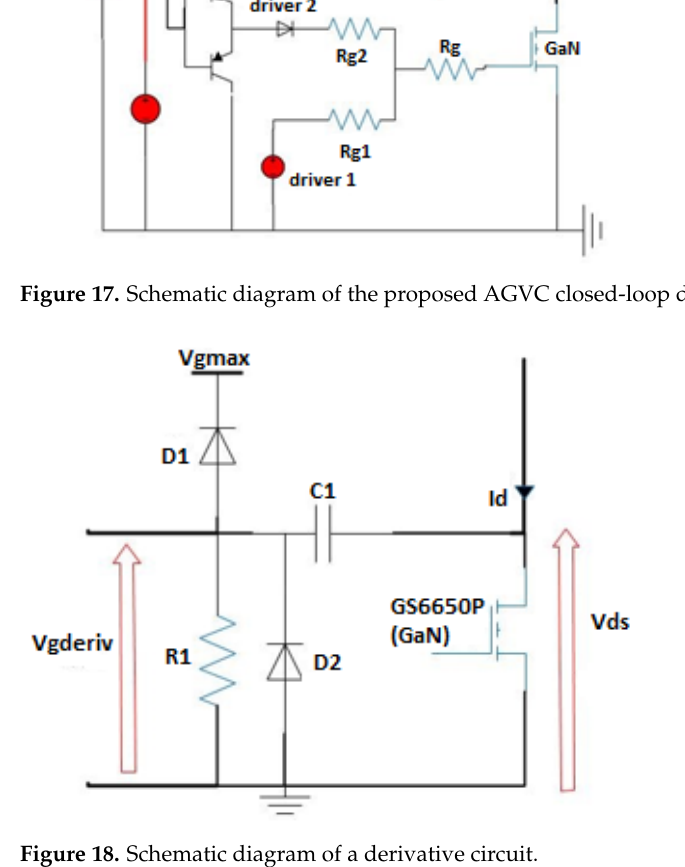
Figure 17. Schematic diagram of the proposed AGVC closed-loop during turn-off.